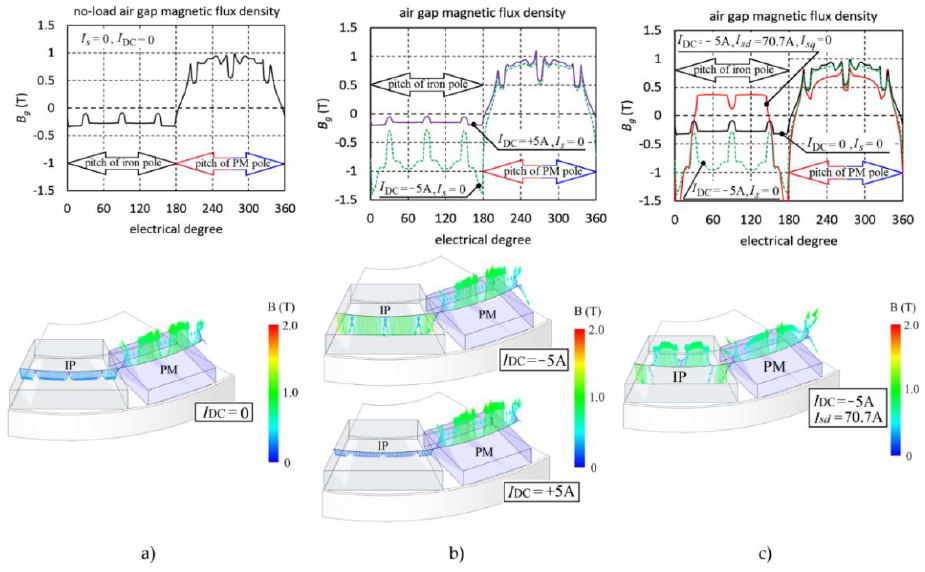
Figure 4. Air-gap magnetic flux density at the different magnetic field distributions I DC = 0, I s = 0 ( a ), I DC = ± 5 A, I s = 0 ( b ) and I DC = − 5 A, I sd = 70.7 A ( c ).